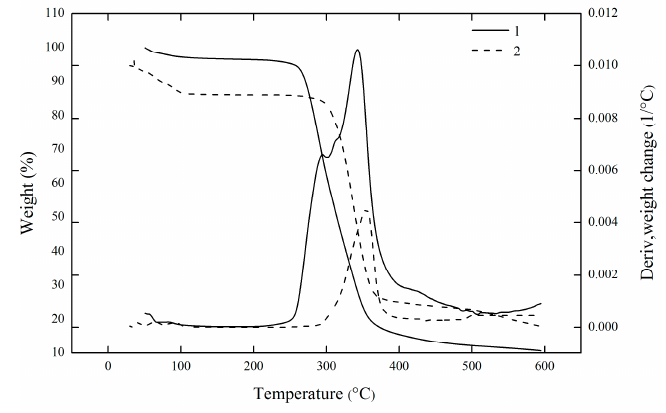
Figure 3. TGA/DTA curves of CAX (curve 1, sample 17 in Table 1) and xylan (curve 2).